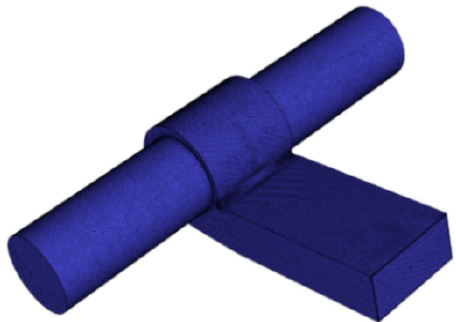
Figure 2. Parametric model of computational domain.